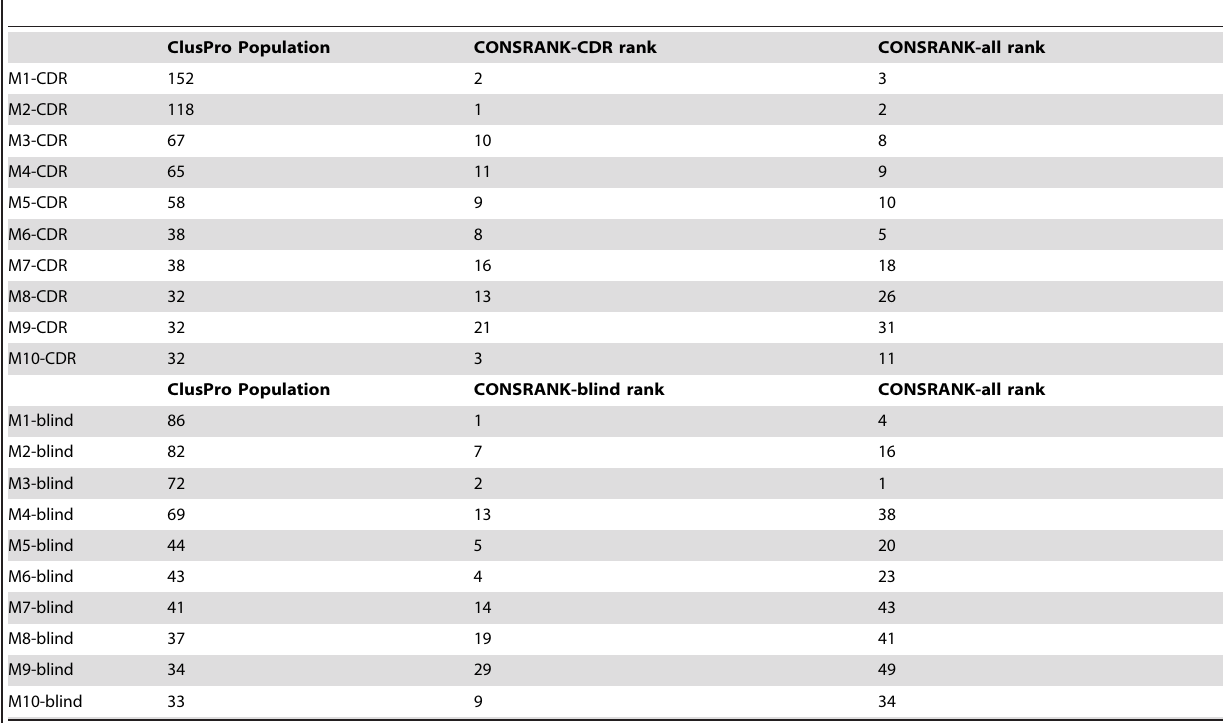
Table 2. Top 10 ClusPro models for the CDR-directed and ‘‘blind’’ simulations, with corresponding ClusPro population and ranking position by CONSRANK.